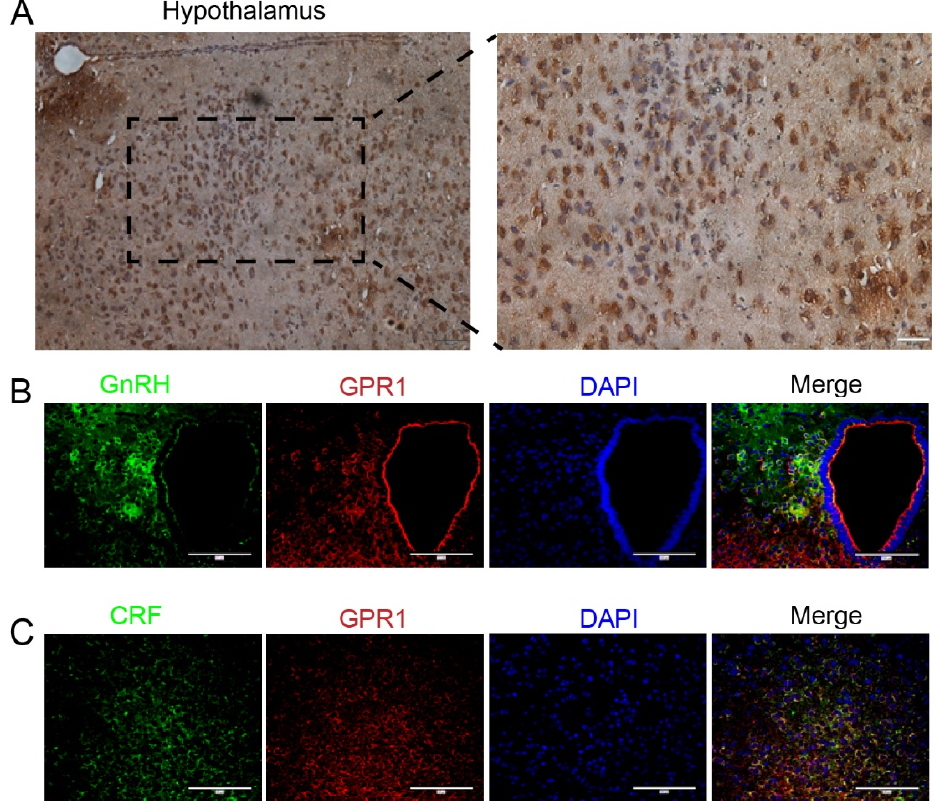
Figure 1. Expression of GPR1 and colocalization of GPR1, GnRH, and CRF in the hypothalamus of female mice. ( A ) Gpr1 expression in the hypothalamus of mice, the brown part of the picture shows GPR1, and the blue part shows a cell nucleus, scale bars represent 50 μ m. ( B ) Representative immunostaining images of GnRH and GPR1 in hypothalamus of female mice. ( C ) Representative immunostaining images of CRF and GPR1 in hypothalamus of female mice. Scale bars represent 100 μ m.